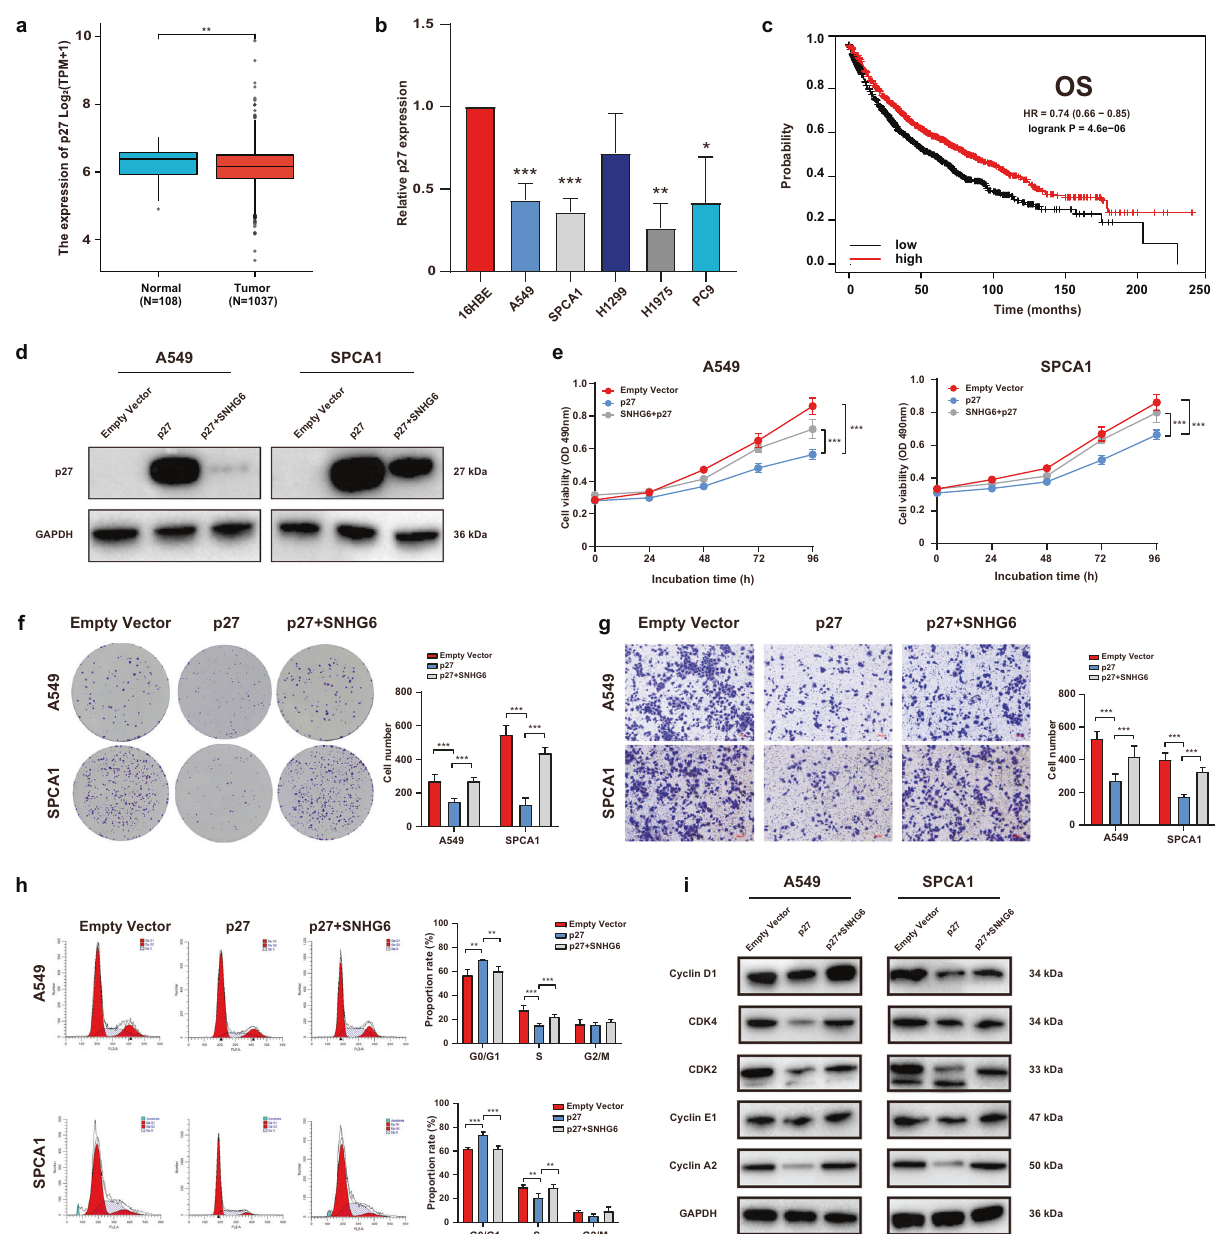
Fig. 5 p27 overexpression suppressed cell biological function, which was partially rescued by SNHG6 overexpression. a , b p27 was downregulated in NSCLC tissues and cells (A549, SPCA1, and, H1975); c lower expression of p27 indicated a poorer prognosis (log-rank test); d Transfection with pcDNA3.1-p27 in NSCLC cells ef fi ciently upregulated the p27 protein expressions while overexpression of SNHG6 reversed the upregulation; e – g Overexpression of p27 inhibited cell proliferation ( e : MTT; f : colony formation) and migration ( g ) while SNHG6 recovered the suppressed cell function. h SNHG6 partly retrieved the declined cell number in the S phase and the increased cell number in the G0/G1 phase that was mediated by p27 overexpression; i p27 downregulated the expression of CCNs and CDKs that function in G1/S transition and SNHG6 partially retrieved the decline. The results were from three independent experiments. Data were analyzed by unpaired student ’ s t -test. *** P < 0.001, ** P < 0.01, * P < 0.05. Variables were presented as the mean ± SD. assays. It indicated that EZH2 showed no signi fi cant variations at prediction using RF classi fi er was 0.7 and the SVM classi fi er was 0.96 mRNA and protein levels after SNHG6 silencing (Fig. 4e). We further (The predictions with probabilities >0.5 were considered positive). carried out the RIP assays to validate the interaction between Using another predictor catRAPID (http://s.tartaglialab.com/page/ SNHG6 and EZH2. It implied that the enrichment of SNHG6 was catrapid_omics2_group), we observed that the overall interaction prominently higher in the anti-EZH2 group compared with anti-IgG score between SNHG6 and EZH2 was 0.54 (Fig. 4d, putative = 0.71, in A549 and SPCA1 cell lines (Fig. 4f). All the fi ndings above classical = 0.6, and non-classical = 0.3, the interaction score manifested that SNHG6 could directly interact with EZH2. >0.5 suggested RNA-binding potential). The potential binding loci Furthermore, two siRNAs were synthesized to downregulate were illustrated in Fig. 4d as well. Subsequently, we assessed the EZH2 in A549 and SPCA1 (Fig. S1c). Consistent with the silencing EZH2 level after SNHG6 knockdown by qPCR and western blot Cell Death Discovery (2022)